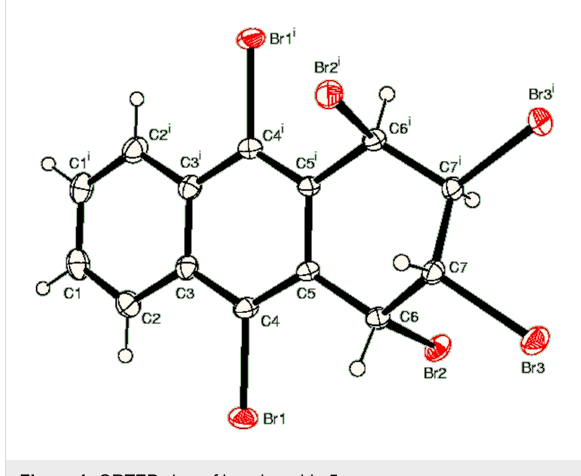
Figure 1: ORTEP view of hexabromide 5.